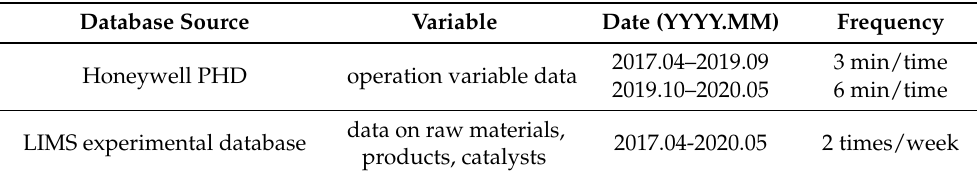
Table 2. Raw data